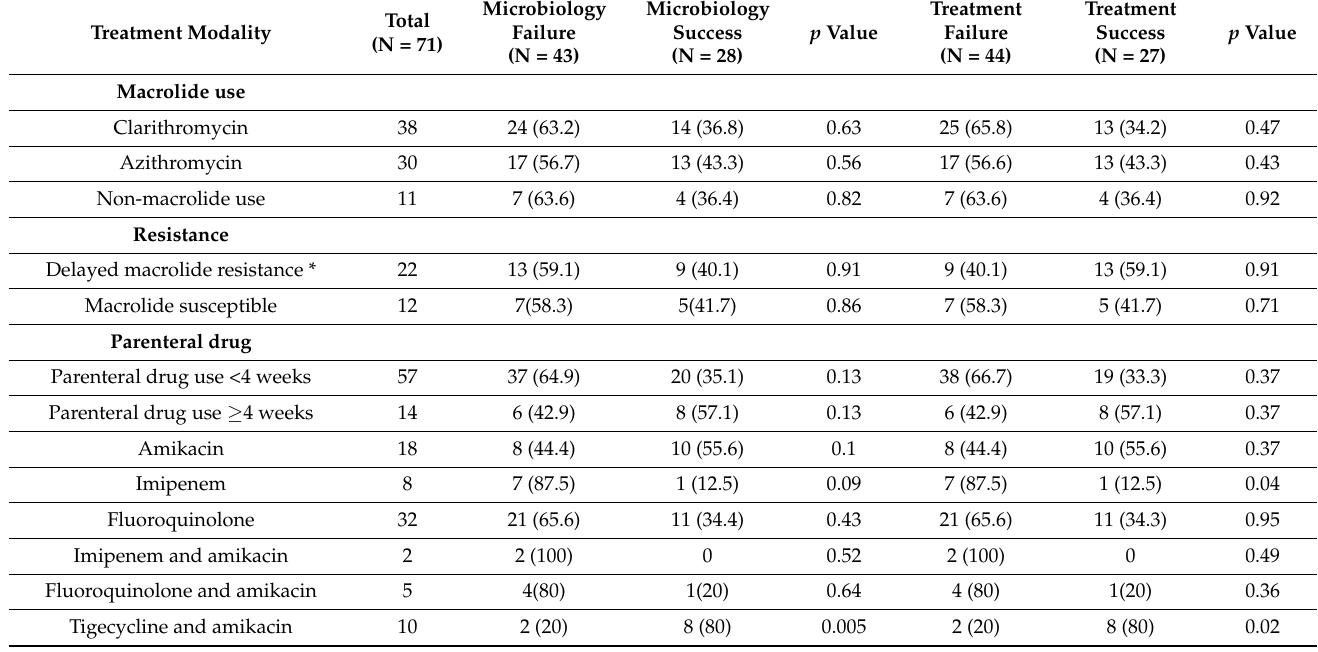
Table 3. Comparing treatment regimen and microbiology in different treatment